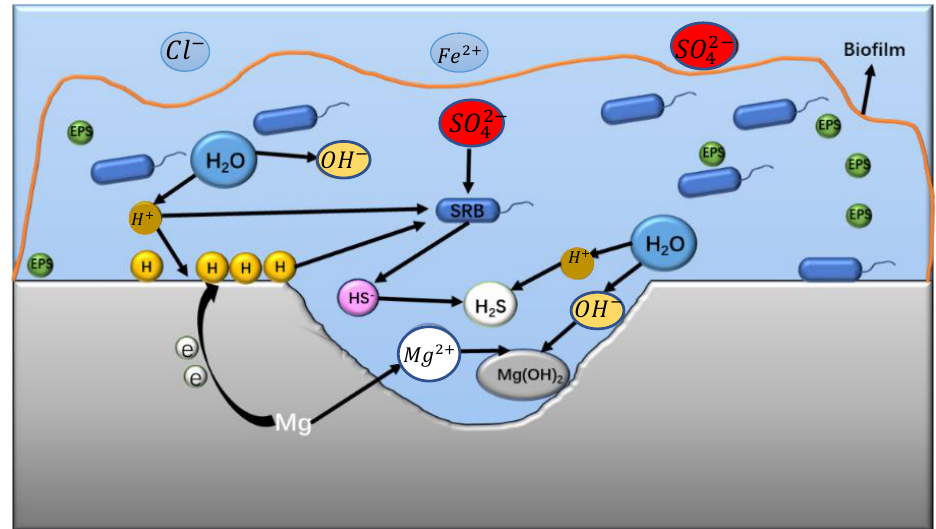
Figure 11. Corrosion mechanism diagram of Mg-Nd alloy in SRB.